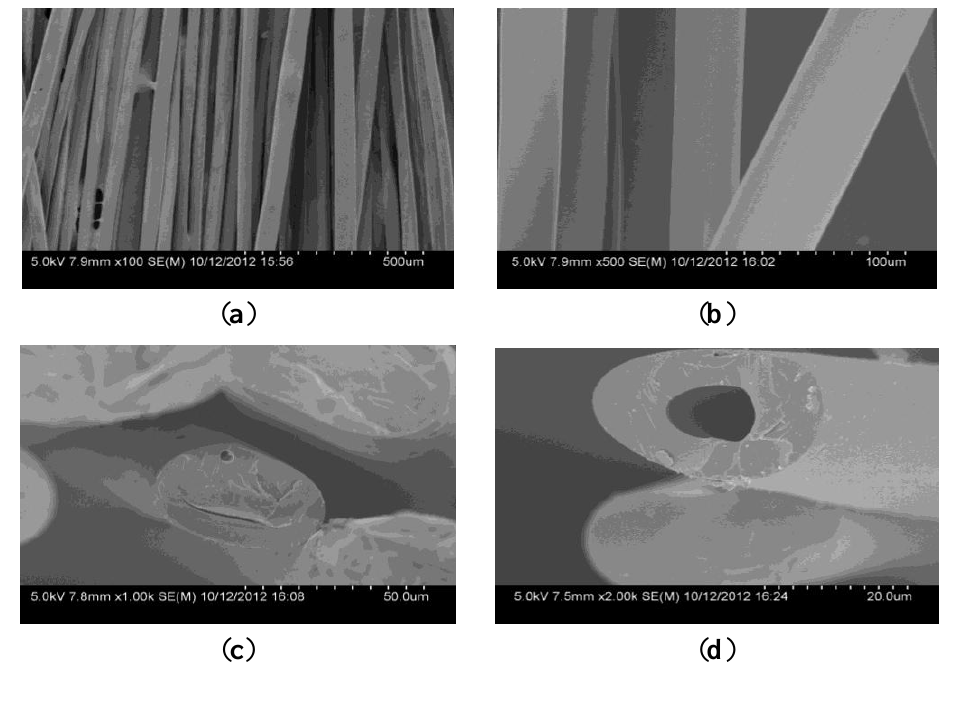
Figure 1. Scanning electron microscopy (SEM) micrographs of Cellulose-based carbon fibers (CBCFs): ( a ) and ( b ) side surface; ( c ) and ( d ) crossing section.